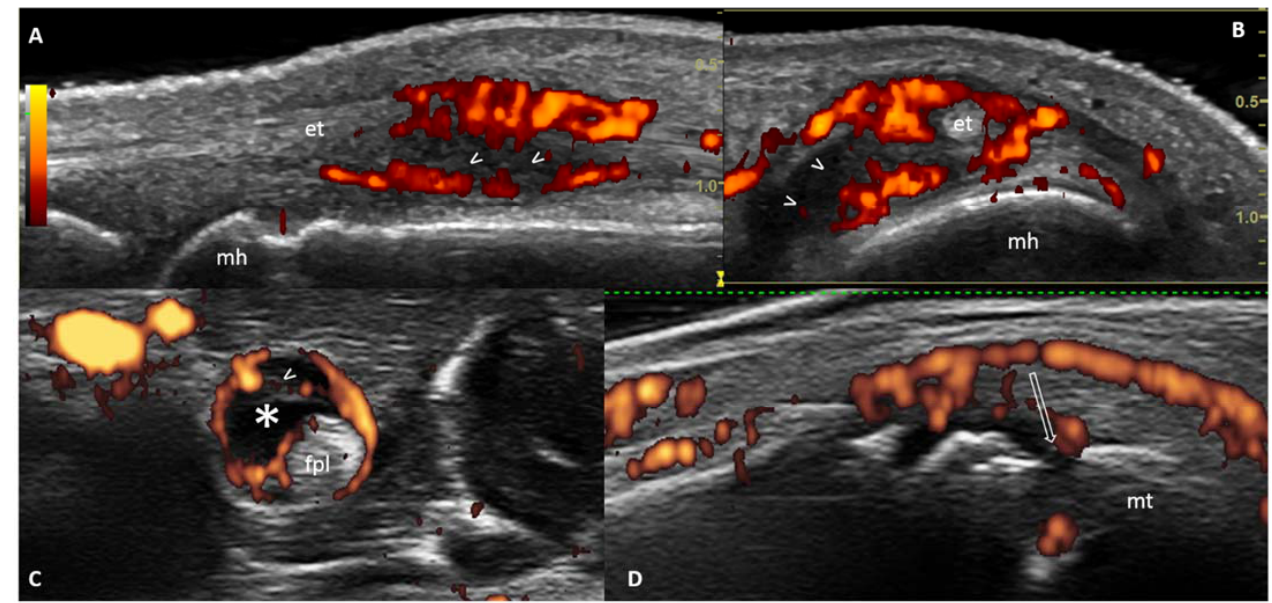
Figure 2. Representative ultrasound (US) findings in at-risk individuals with musculoskeletal symptoms but without clinical arthritis. Longitudinal ( A ) and transverse ( B ) US scan of the dorsal aspect of the 3rd metacarpophalangeal joint. US shows the presence of “active” synovitis, characterized by synovial hypertrophy (arrowheads) with PD signal (red spots) which also envelops the finger extensor tendon (et). ( C ) Transverse US scan of the flexor pollici longus tendon shows “active” tenosynovitis with synovial effusion (asterisk) and synovial hypertrophy (arrowhead) within the tendon sheath (asterisk) surrounded by PD signal (red spots). ( D ) Longitudinal US scan of the lateral aspect of the 5th metatarsophalangeal joint. Note the presence of a bone erosion (empty arrow) filled with power Doppler signal (red spots). Legend: et = finger extensor tendon; fpl = flexor pollici longus; mh = metacarpal head; mt = metatarsal head. (( A ) Di Matteo, personal images).